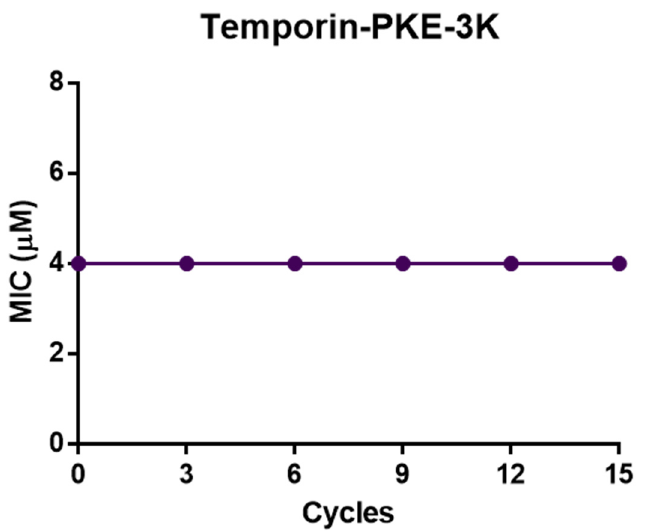
Figure 12. The assessment of the resistance induction of temporin-PKE-3K in K. pneumoniae after 15 cycles. The vertical axis represents the MIC value (µM) of temporin-PKE-3K, and the horizontal axis represents the number of passages.